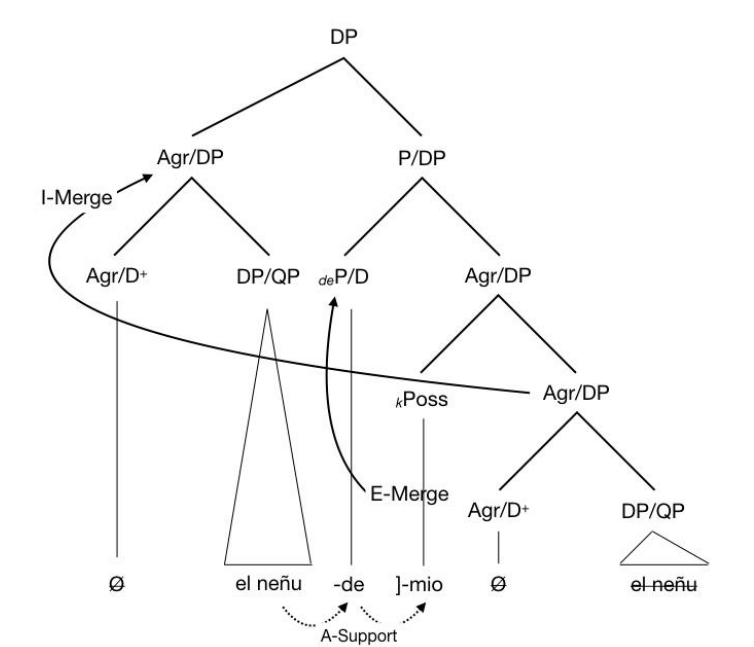
Figure 9. Periphrastic possessive construction (Type IV: e.g. el neñu de mio )